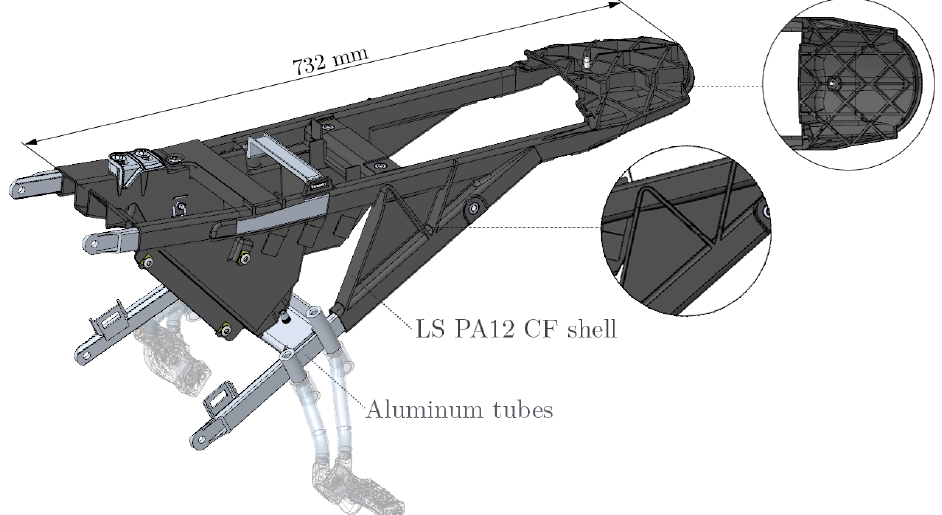
Figure 1. Rendering of an off-road motorcycle rear frame consisting of aluminum tubes and a LS PA12 CF structure featuring shells in various orientations and wall thicknesses. Reproduced with permission from KTM E-TECHNOLOGIES GmbH,